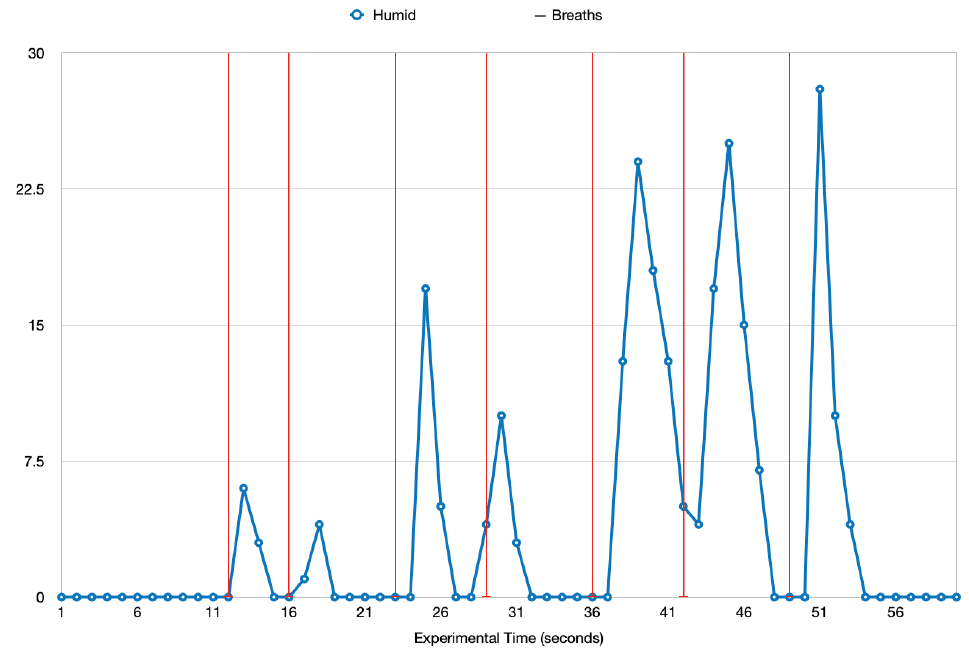
Figure 11. Humidity Readings and Breaths Taken.